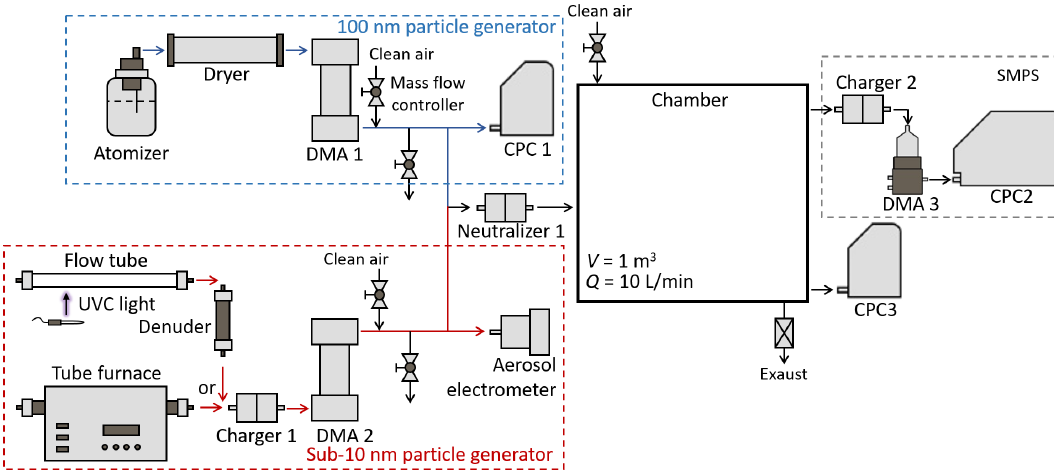
Figure 1. Schematic of the chamber experiment setup for measuring the size-dependent coagulation